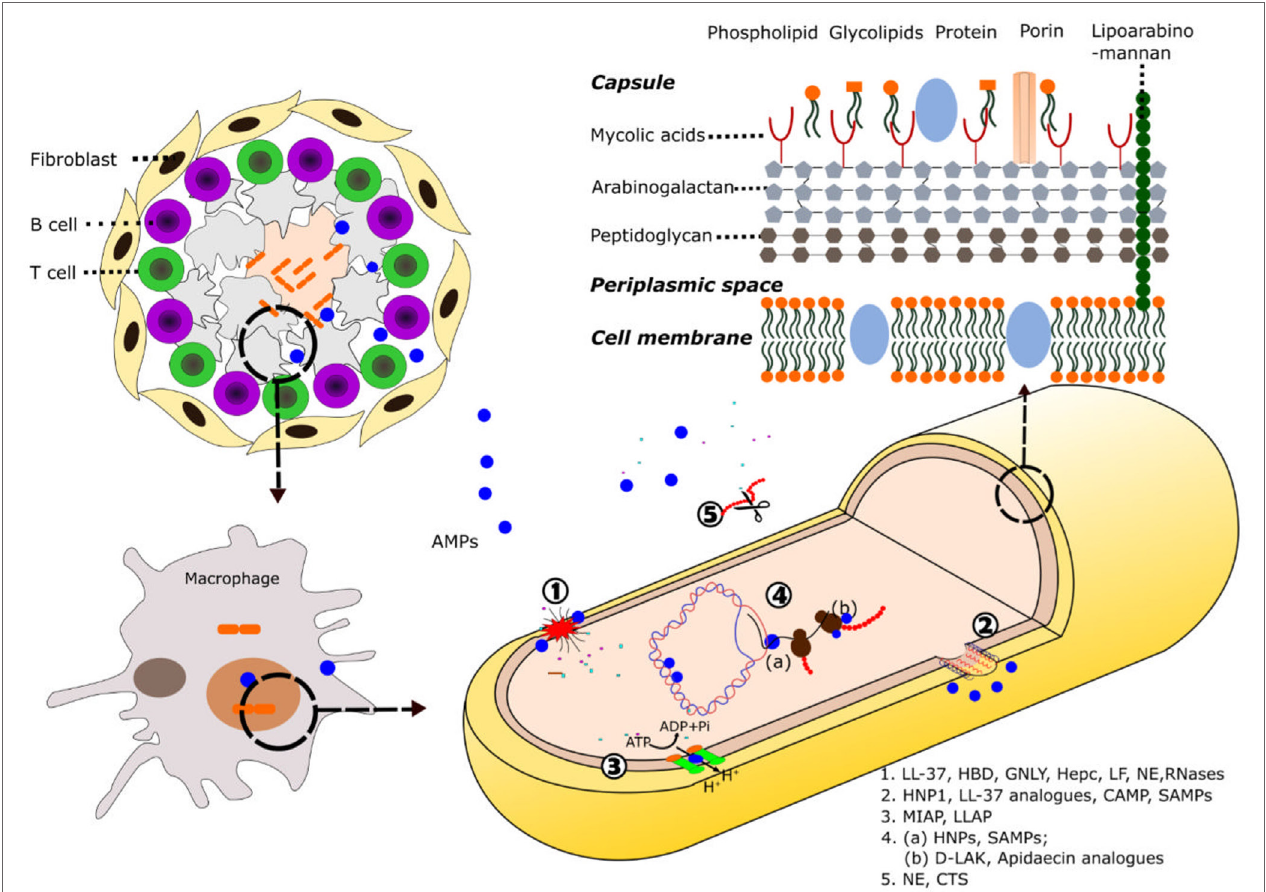
FiGURe 1 | Schematic illustration of AMP mode of action against mycobacteria. Following induction of the immune response by mycobacteria, AMPs are directed toward the area of infection where they can be recruited into the granuloma. At the cellular level, the destruction of the pathogens takes place inside the macrophage phagolysosomes. Composition of the mycobacteria cell wall and the main described mechanisms of action of AMPs against mycobacteria are shown : (1) cell wall and plasmatic membrane disruption, (2) membrane pore formation, (3) inhibition of ATPase, (4) AMP intracellular targets: (a) nucleic acids binding, inhibition of replication, and transcription; (b) inhibition of translation, and (5) protein degradation. Selected AMPs for each activity are highlighted. See Tables 1 and 2 for a detailed description of each AMP mechanism of action. Abbreviation : LL-37, cathelicidin C-terminus; HBD, human β -defensin; GNLY, granulysin; Hepc, hepcidin; LF, lactoferrin; NE, neutrophil elastase; HNPs, human neutrophil proteins; CAMP, cationic antimicrobial peptides; SAMPs, synthetic antimicrobial peptides; MIAP, magainin-I derived antimicrobial peptide; LLAP, LL-37 derived antimicrobial peptide; d -LAK, d -enantiomeric antimicrobial peptides; CTS, cathepsins.